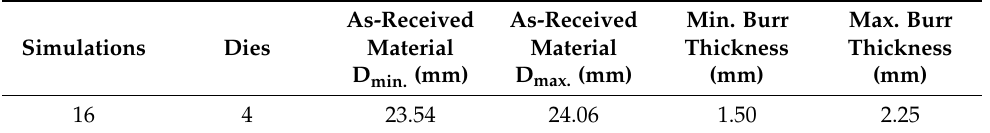
Table 4. Simulations of the forming process of the head of the screw spike.